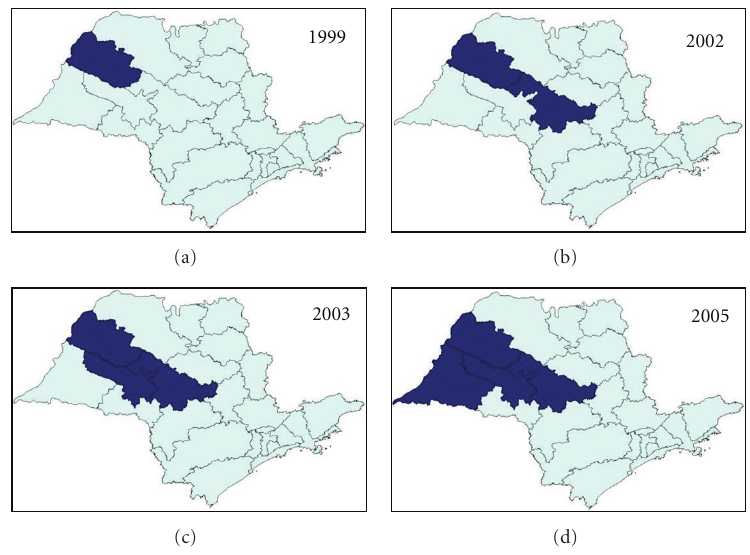
Figure 1: Geographic expansion of confirmed cases of visceral leishmaniasis autochthonous transmission, according to the region of Sao Paulo state, from 1999 to 2005. Data source: SINANW-National Surveillance System for Disease Notification/CVE/SES/SP; TABWIN 3.1.